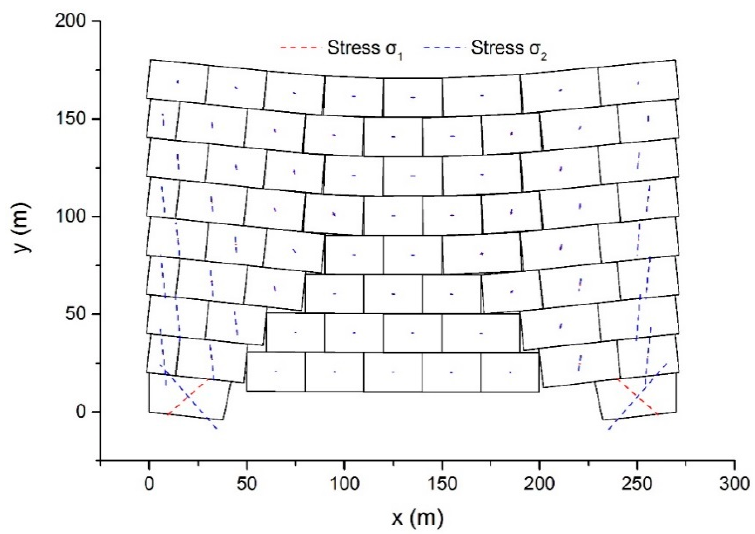
Figure 12. The configurations and main stresses after 7 s using the proposed method. First, at the bottom, the central blocks descend because of the absence of supports. Next, the middle blocks subside one layer after another. Simultaneously, the movement of the middle blocks leads to rotation and inclination of the left and right blocks. Submitting to the gravitational force of the upper blocks, the bottom two blocks become deformed. After 7 s elapsed, the top boundary of the model appears to be a gentle curve. The stress value of the blocks in the middle is rather small compared to the blocks in other regions, and the two bottom blocks suffer the largest stress. In the bottom right block, the main stresses are σ 1 = 560 kPa and σ 2 = − 880 kPa and the direction of the minimum principal stress is − 48°.